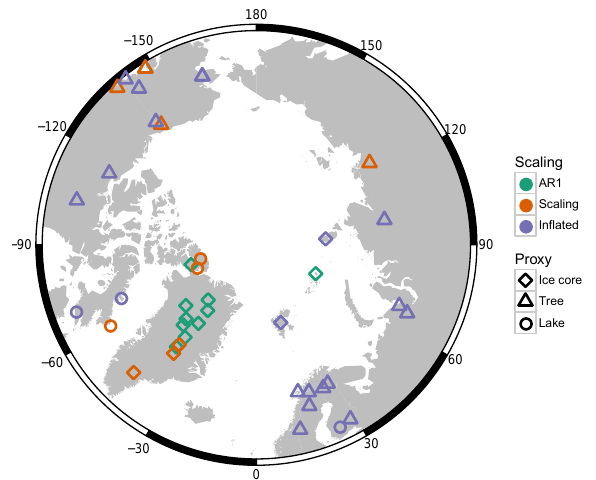
Figure C1. Proxy type (triangles: ice cores; diamonds: tree rings; squares: lake sediments) and persistence properties are colour coded.